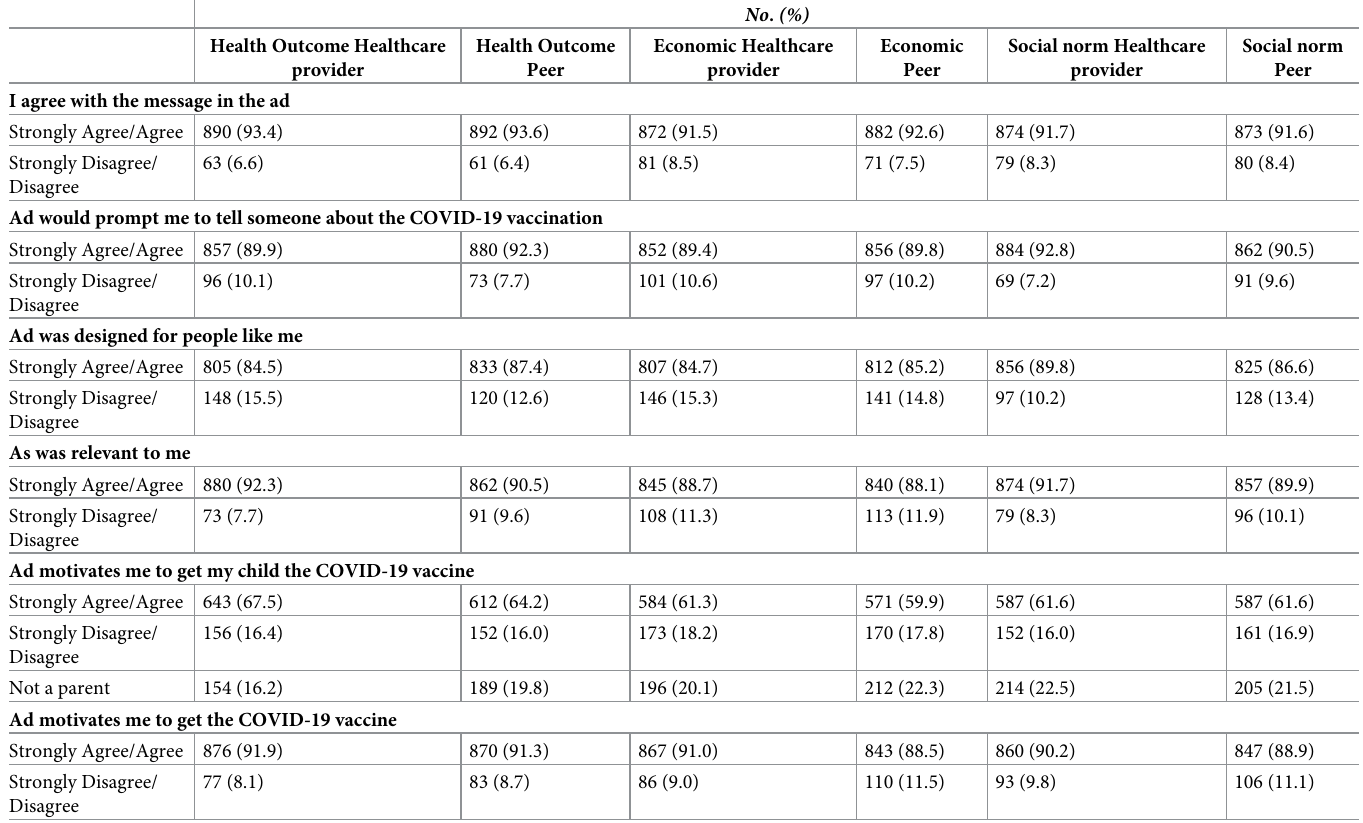
Table 2. Participant preferences for message aspects across six ads (n = 935).